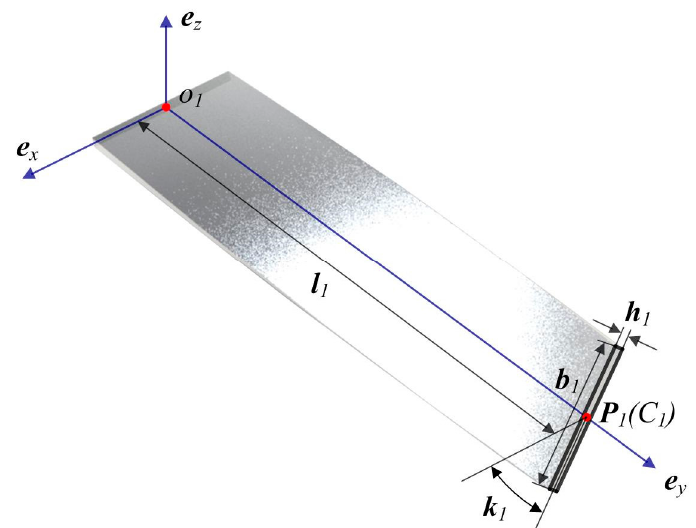
Figure 2. Geometries of a pre-twisted structure with rectangular cross section.